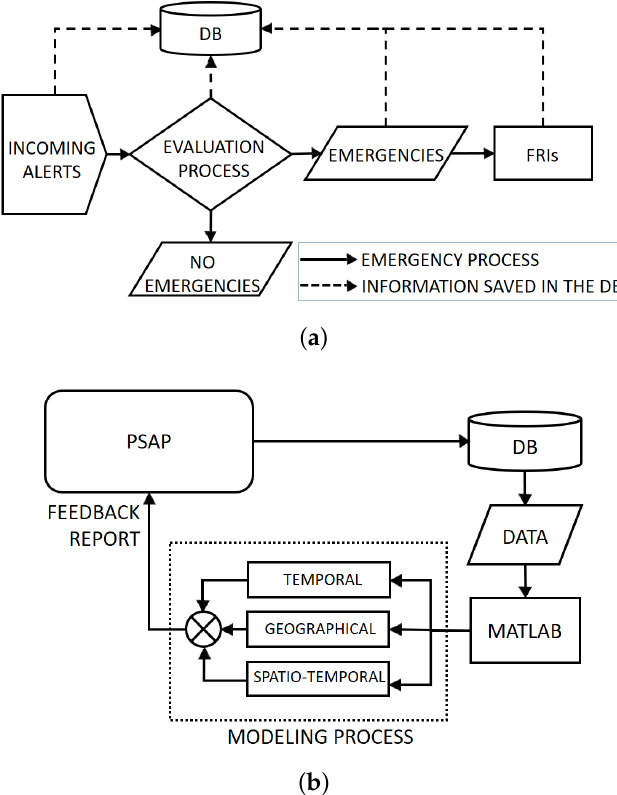
Figure 1. Overview of a public safety answering point (PSAP): ( a ) basic operation; ( b ) proposed model. DB: database; FRIs: first response